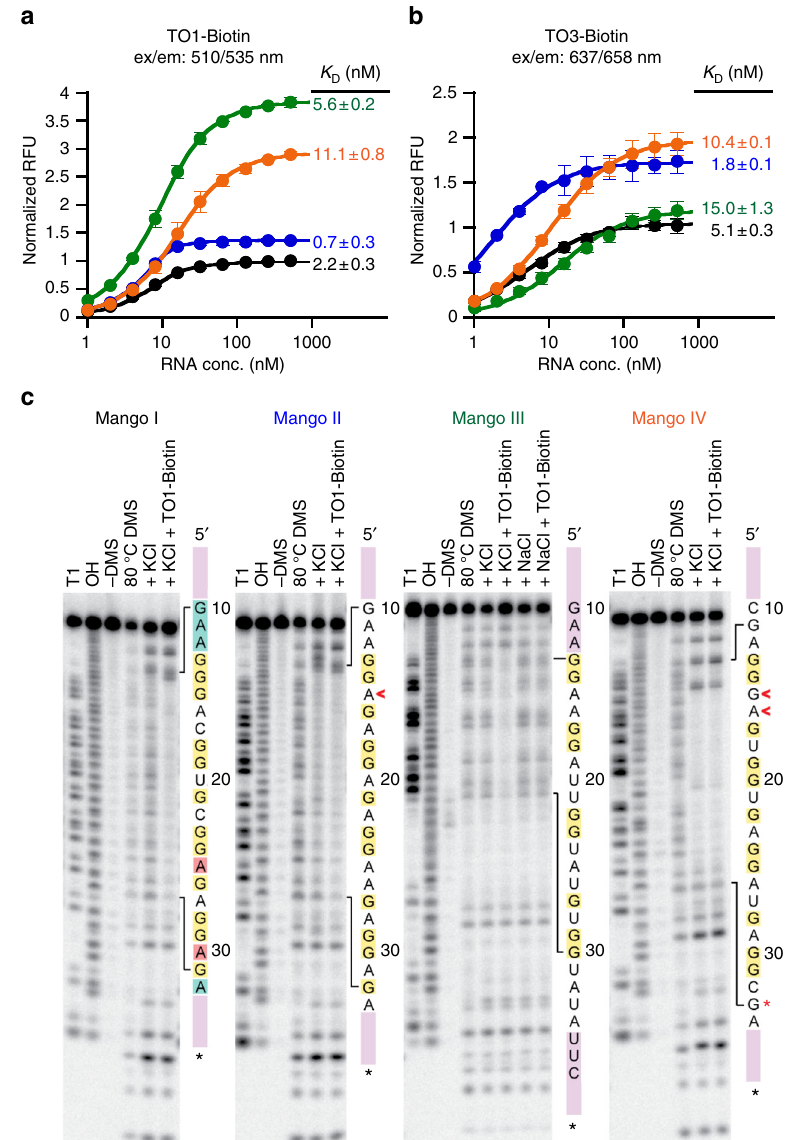
Fig. 3 RNA Mango aptamers fl uorophore-binding and DMS protection. a Fluorescence binding curves for each Mango aptamer determined by titrating RNA aptamer concentration while holding TO1-B fl uorophore constant at 10 nM. K D values are shown next to each titration. b Same as for a but using 1.4 nM TO3-Biotin. Data for a and b have been normalized such that Mango I has a maximum RFU of 1 in each case. Error bars are standard deviation of three replicates. c DMS chemical protection patterns for the four Mango aptamers. 3 ′ end-labelled RNA ( 32 P pCp shown as a black asterisk) was subjected to DMS chemical modi fi cation followed by reduction by NaBH 4 and aniline cleavage as described in the methods. RNA sequences are displayed to the right of each set of lanes with stem portions represented as purple blocks. Legend: T1 — denatured T1 ladder; OH — partial alkaline hydrolysis ladder; ( − ) DMS — denatured reaction with ddH 2 O added in place of DMS; 80 °C DMS — denatured DMS ladder; remaining lanes are native DMS reactions with addition of potassium to 140 mM fi nal (+KCl), addition of sodium to 140 mM fi nal (+NaCl), with or without 500 nM TO1-B (+TO1-B). Red asterisk indicates a notably unprotected G in Mango IV. Red daggers in Mango II and Mango IV indicate nucleotides presumed to be looped out in the T3 layer relative to the Mango I G stack shown in Fig.